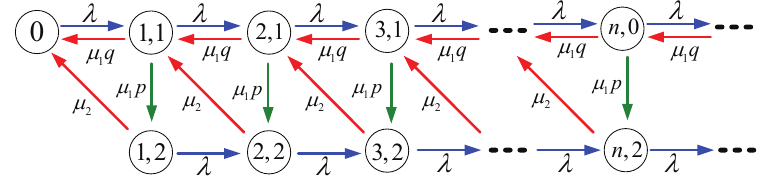
Figure 2. State transition relation of the